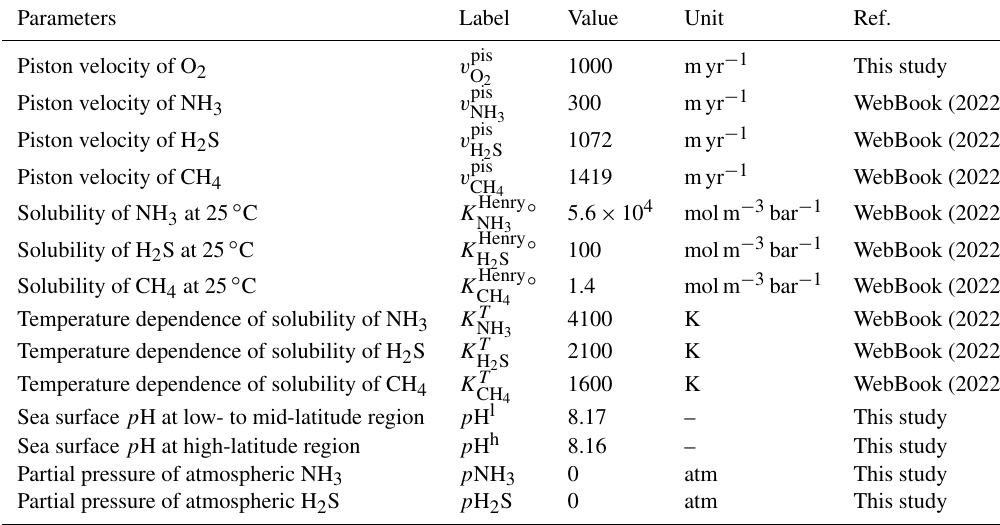
Table 7. Parameters used in the air–sea exchange module of CANOPS-GRB. Parameters Label Value Unit Ref. Piston velocity of O 2 v pis 1000 myr − 1 This study O 2 Piston velocity of NH 3 myr − 1 Piston velocity of H 2 S